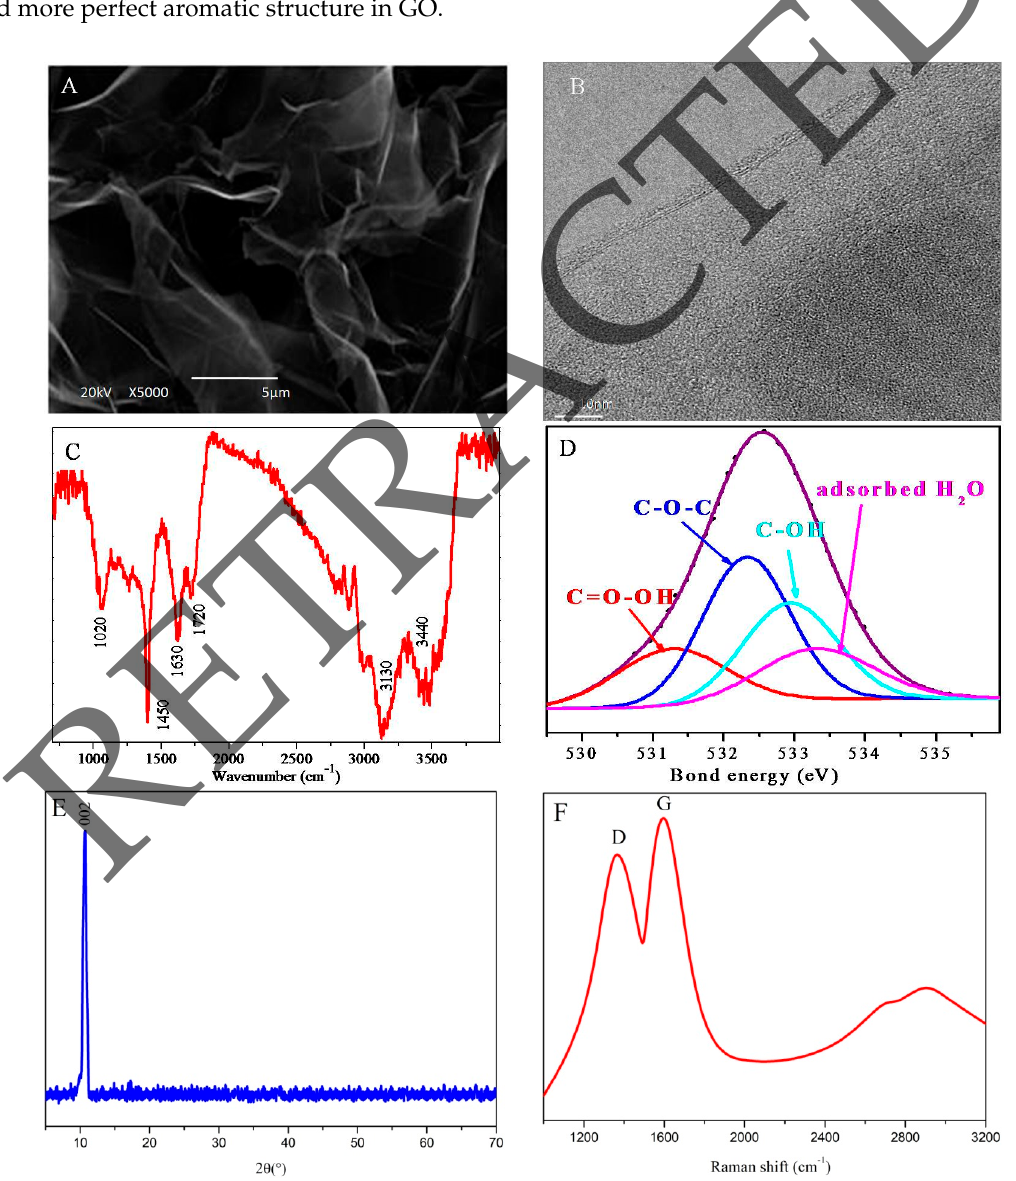
Figure 1. Characterization of GO (( A ) SEM image; ( B ) TEM image; ( C ) FTIR spectrum; ( D ) XPS; ( E ) XRD; ( F ) Raman).